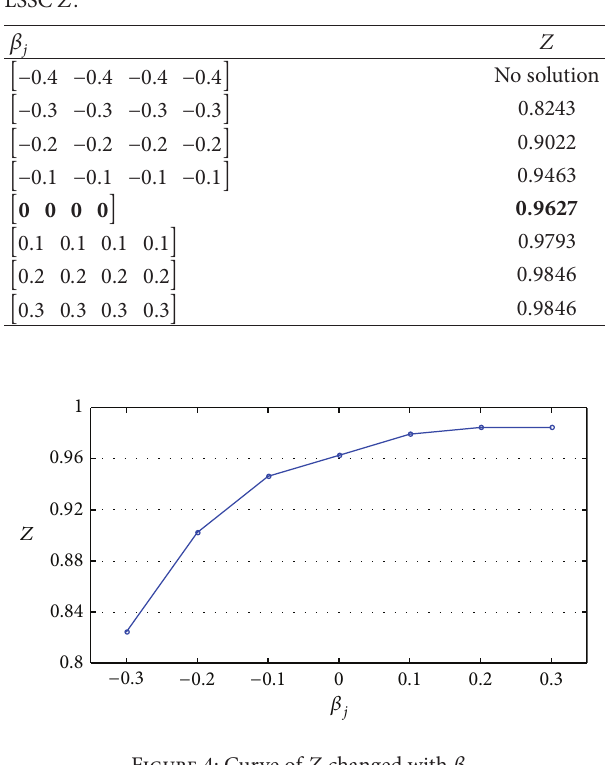
Table 5: Effect of 𝑁 𝑗 on comprehensive performance of LSSC 𝑍 . 0 +1